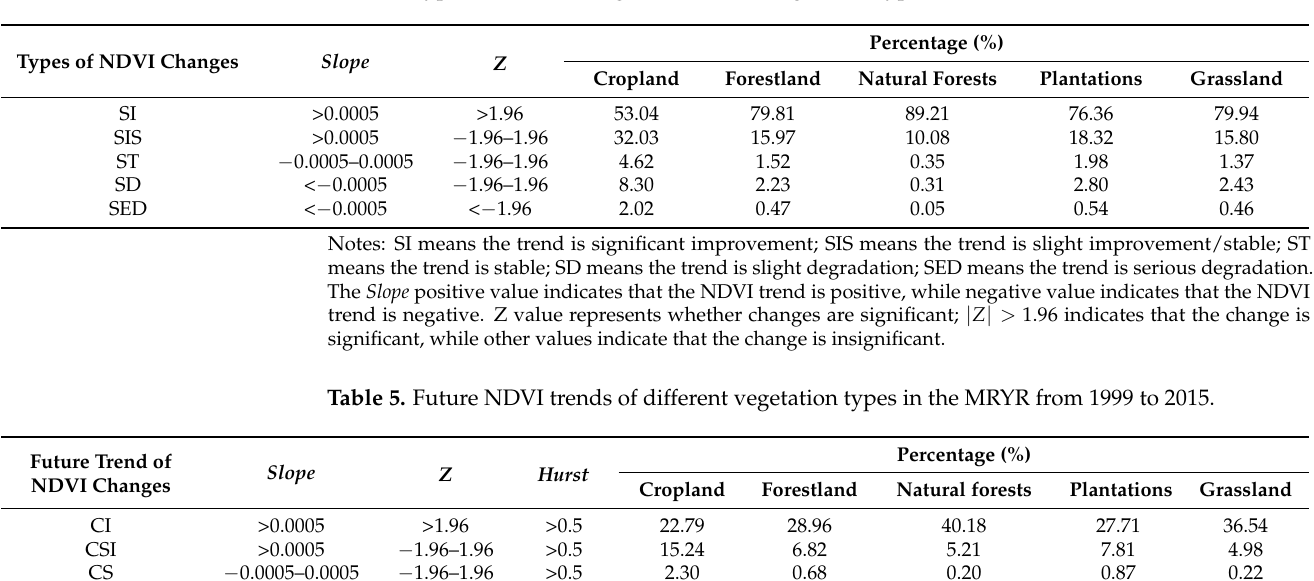
Table 4. Types of NDVI changes in different vegetation types in the MRYR from 1999 to 2015.